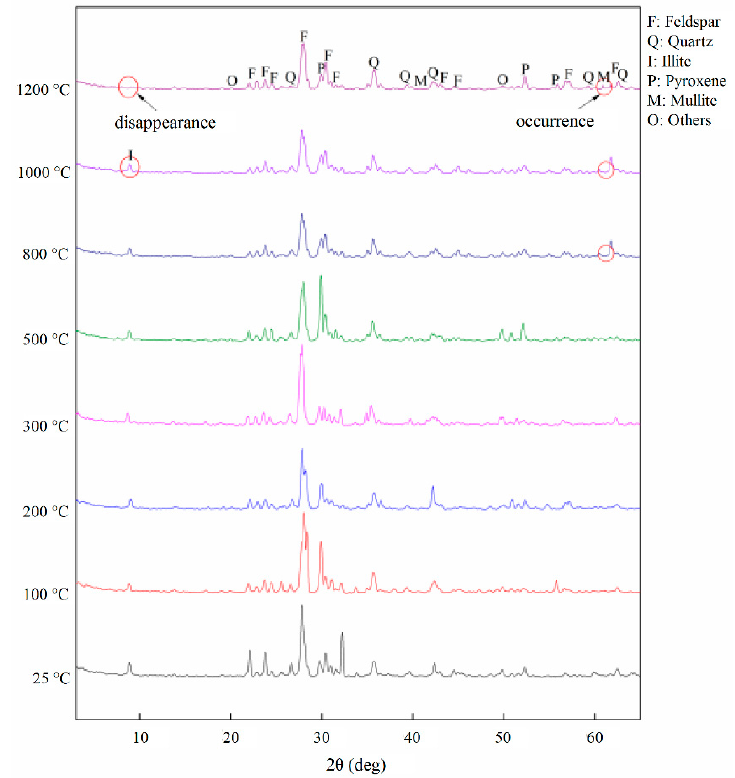
Figure 3. X-ray di ff raction (XRD) patterns of granite at di ff erent heating temperatures from 25 ◦ C to Figure 3. X-ray diffraction (XRD) patterns of granite at different heating temperatures from 25 °C to 1200 ◦ 1200 °C.